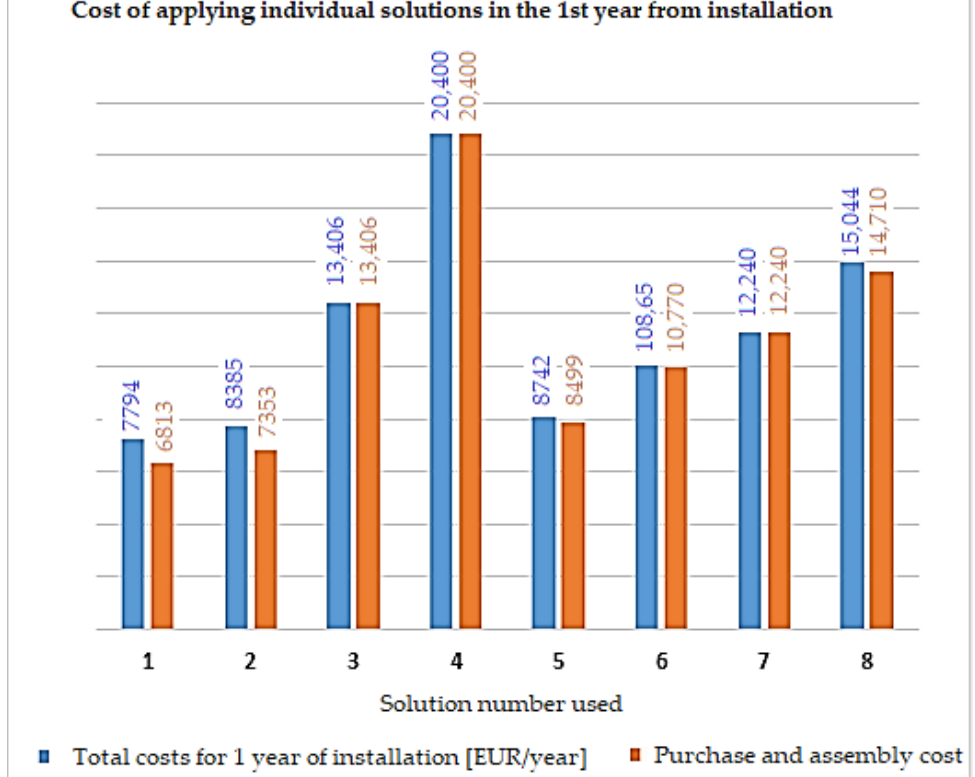
Figure 5. The sum of the costs of applying individual solutions in the first year of installation: (1) 11.6 kW air-to-water heat pump; (2) ground source heat pump 12.5 kW; (3) 11.6 kW air-to-water heat pump + 8.4 kWp monocrystalline photovoltaic panels; (4) induction boiler 21 kW + 28.7 kWp monocrystalline photovoltaic panels; (5) 11.6 kW air-to-water heat pump + 2.2 kW wind turbine with a horizontal axis of rotation; (6) 11.6 kW air-to-water heat pump + 2 kW wind turbine with a vertical axis of rotation; (7) induction boiler 21 kW + wind turbine with a horizontal axis of rotation of 7.5 kW; (8) induction boiler 21 kW + wind turbine with a vertical axis of rotation 6 kW. Source: own study.